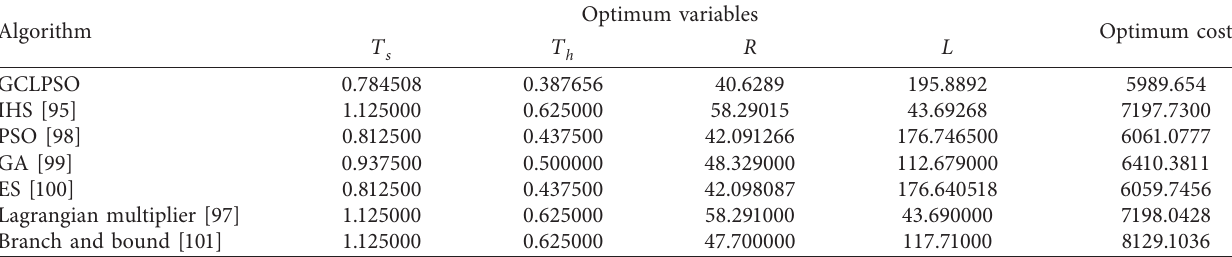
Table 11: Comparison of the GCLPSO with other methods for the pressure vessel design problem.